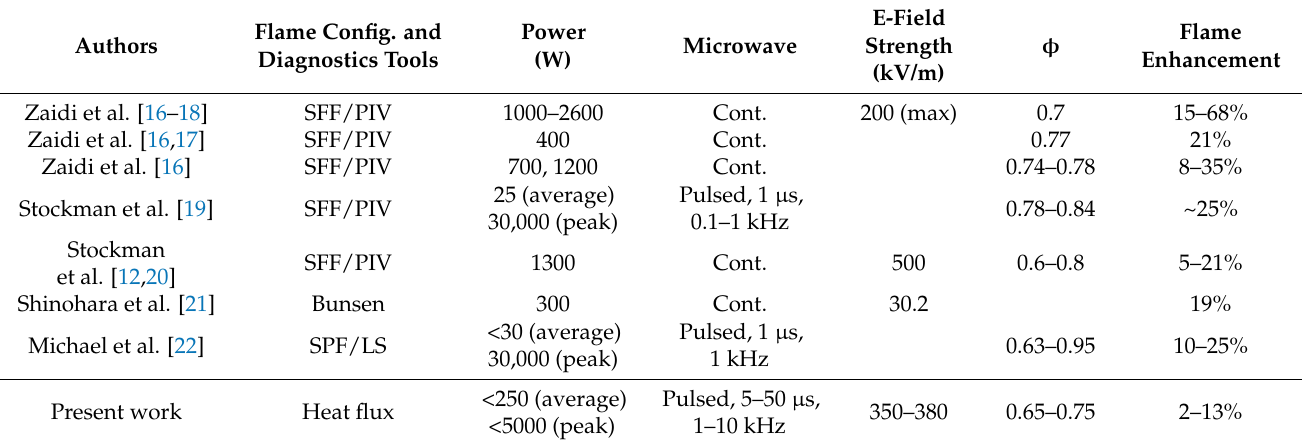
Table 1. Literature studies reporting on enhanced laminar burning velocity of methane/air flames as a result of microwave irradiation publications after 2000. LP—Laminar Premixed; SFF—Stagnation Flat Flame; SPF—Spherically Propagating Flame; PIV—Particle Image Velocimetry; LS—Laser